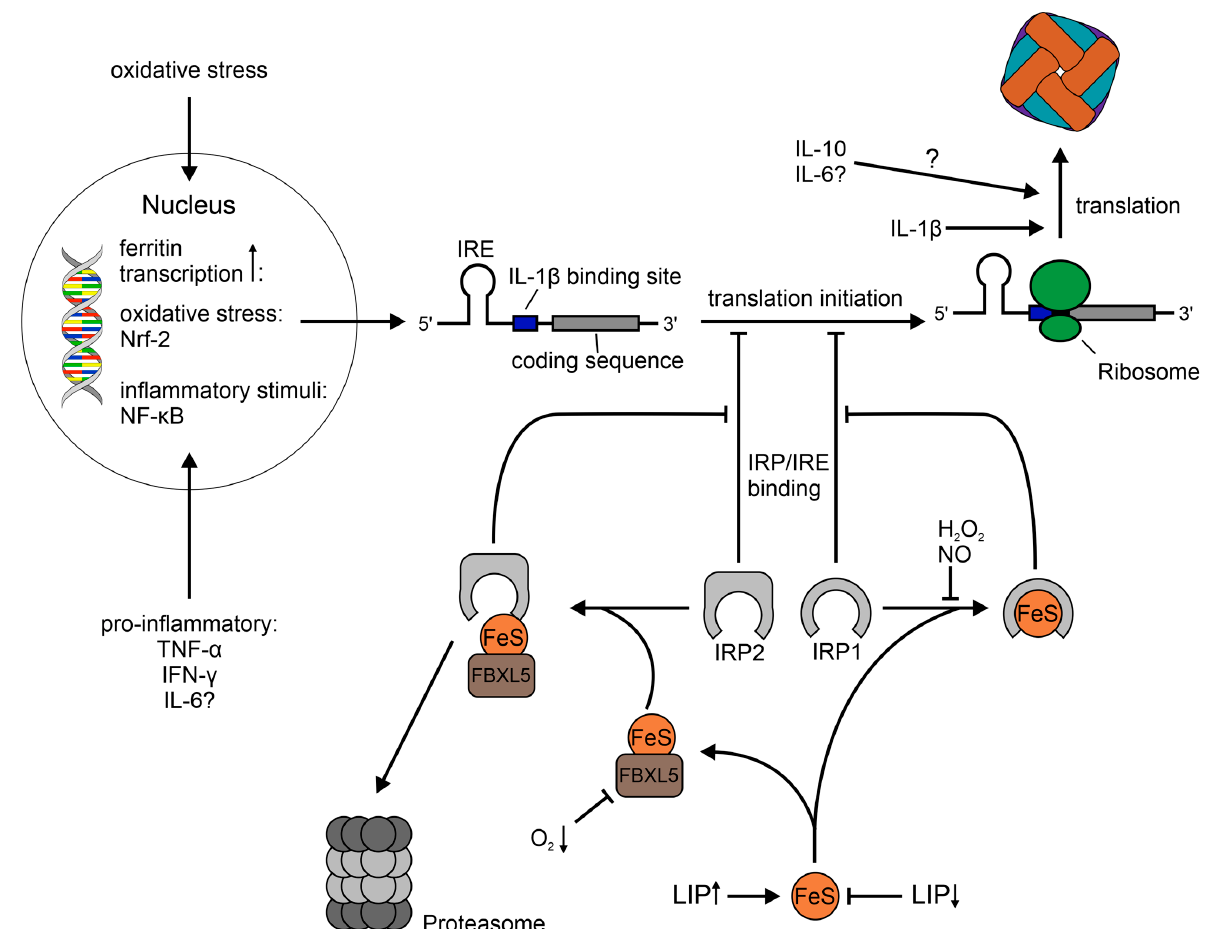
Figure 1. Simplified schematic depiction of regulatory mechanisms influencing ferritin expression. Ferritin transcription has been shown to be induced by oxidative stress and the pro-inflammatory cytokines TNF- α and IFN- γ via their downstream signals. IL-6 is associated with increased ferritin protein expression. However, it is not established whether this happens on a transcriptional or post-transcriptional level. The ferritin mRNA transcript possesses regions in it 5 (cid:48) UTR, namely IRE, an IL-1 β -binding site and a binding site for eIF3 (not shown), which affect the translation of ferritin. If the cellular iron content is low, the iron–sulfur cluster synthesis is reduced, which enables IRP1 and IRP2 to bind the IRE on ferritin mRNA and subsequently block the translation. If the cellular iron content is high, IRP1 moves from the IRE, while binding an iron-sulfur cluster, becoming cytoplasmic aconitase. Furthermore, FBXL5 binds an oxygen-responsive iron–sulfur cluster and mediates the proteasomal degradation of IRP2. The IRP1/IRE binding is enhanced by H 2 O 2 and NO, while the effects of other ROS and RNS on the IRE-binding capability of IRP1 and IRP2 are hitherto unclear (not shown). IL-10 increases ferritin protein expression on a post-transcriptional level. However, the specific mechanism is hitherto not resolved. The translation of ferritin is enhanced in the presence of IL-1 β by binding to a guanine and cytosine-rich domain in the 5 (cid:48) -UTR of ferritin mRNA. Hitherto unknown or unresolved mechanisms are highlighted with a question mark. Nrf-2: nuclear factor erythroid 2-related factor 2, NF- κ B: nuclear factor κ B TNF- α : tumor necrosis